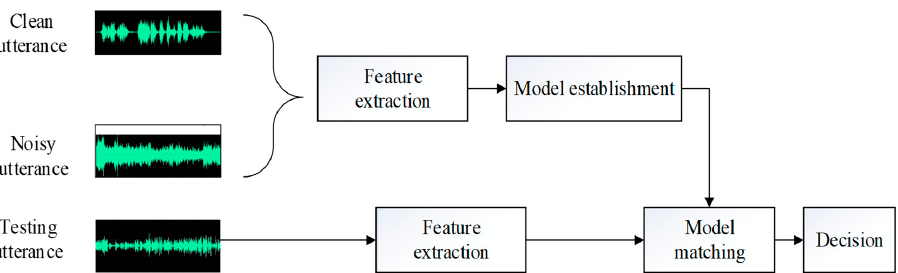
Figure 5. Source cell-phone identification algorithm block diagram of multi-scene training.